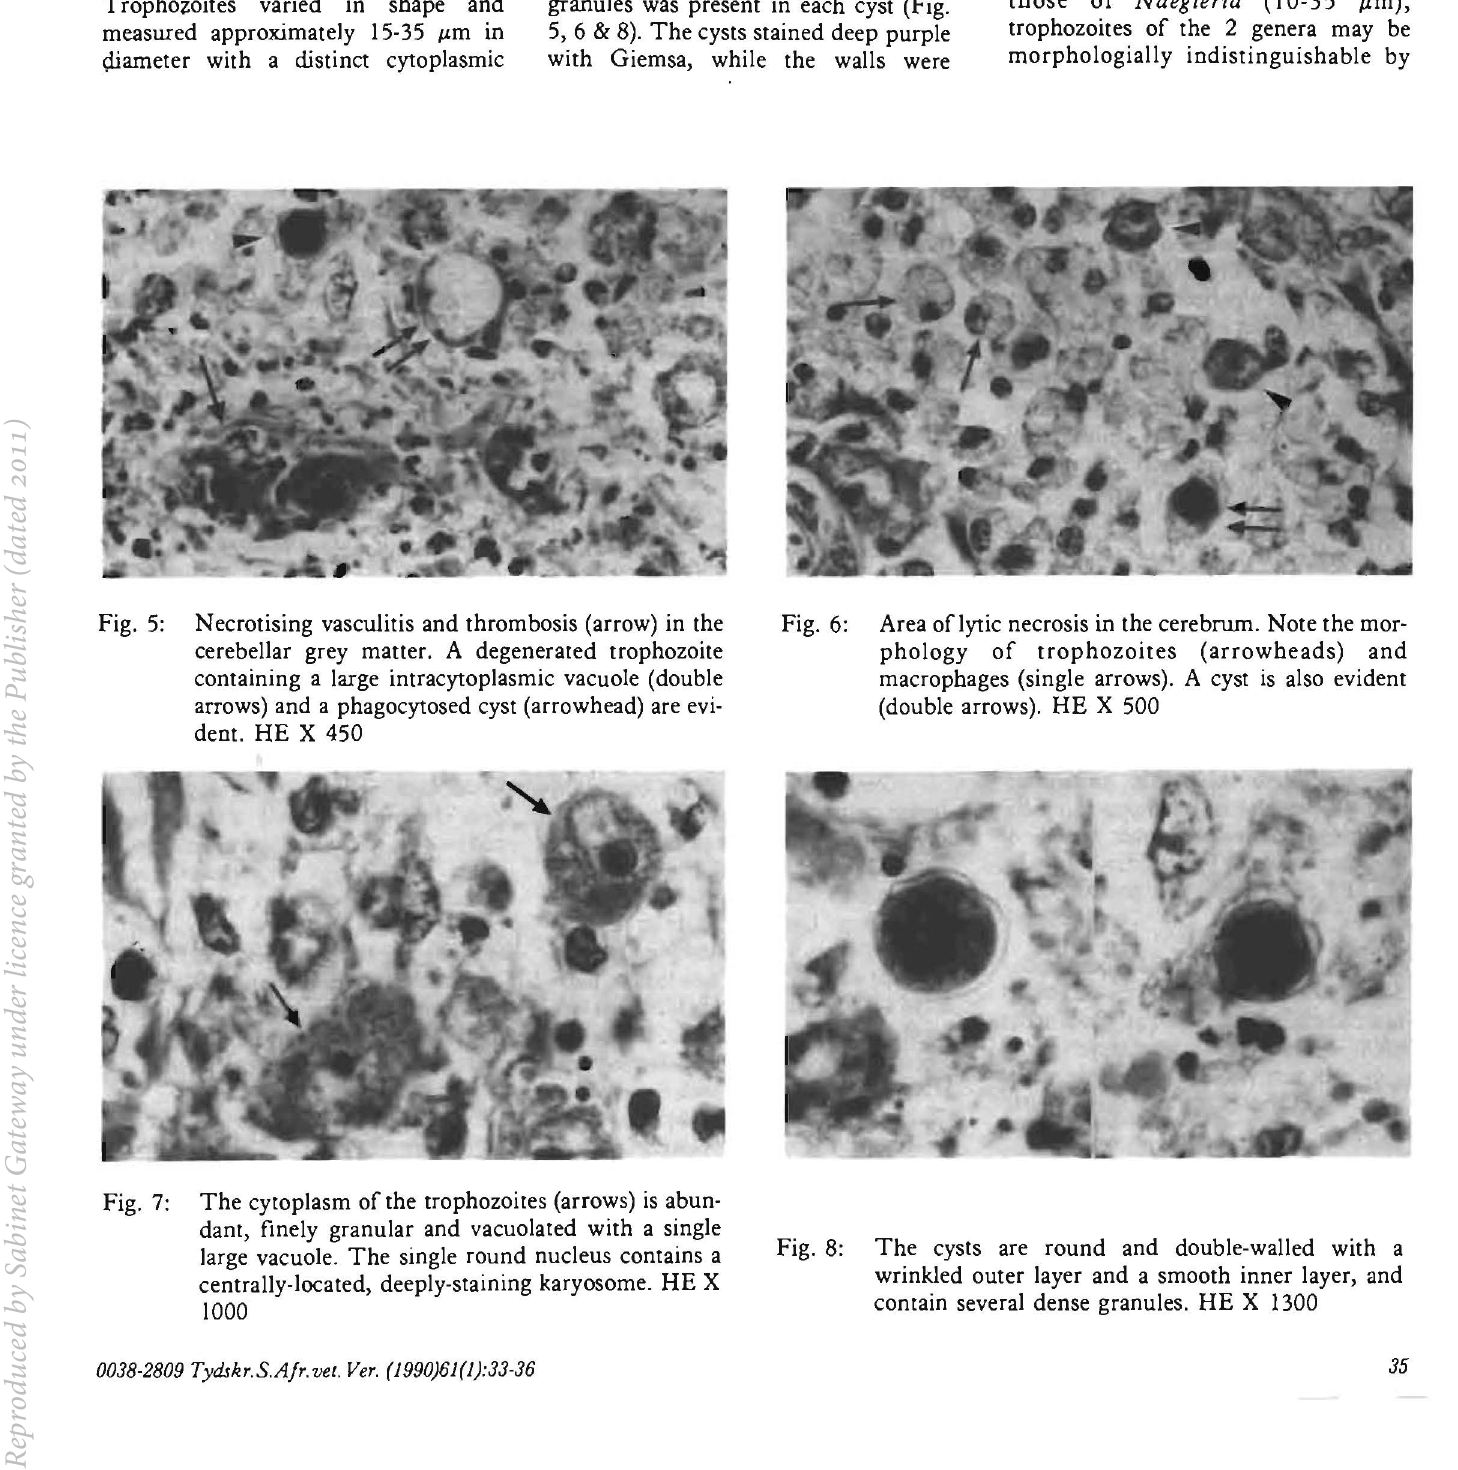
Fig. 8: The cysts are round and double-walled with a wrinkled outer layer and a smooth inner layer, and contain several dense granules. HE X